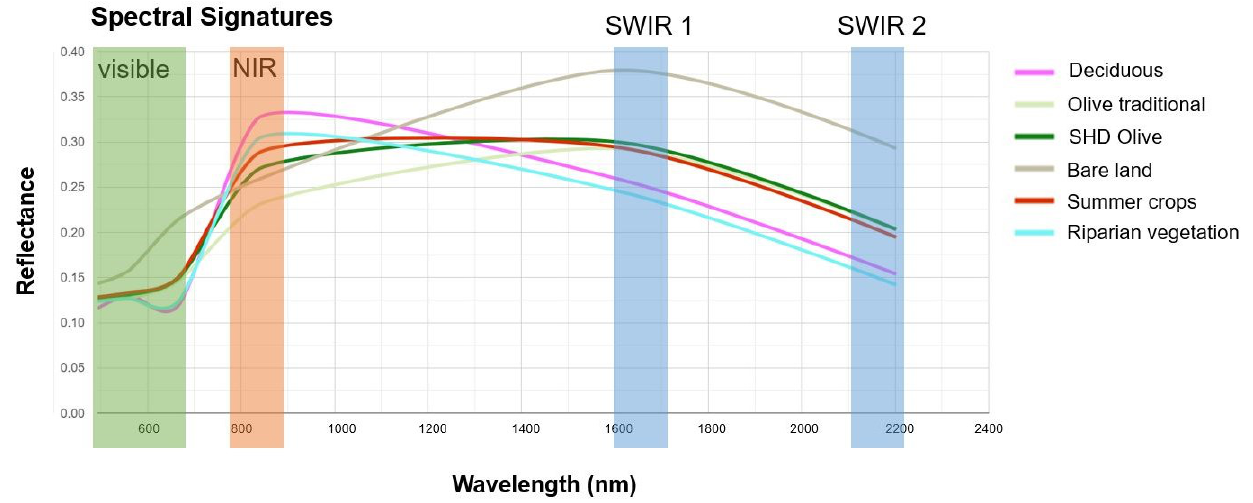
Figure 9. Spectral signatures of selected crops collected from the image interpretation of NDVI Sentinel-2 classes reveal larger differences in NIR and SWIR wavelengths than in the visible range during July.